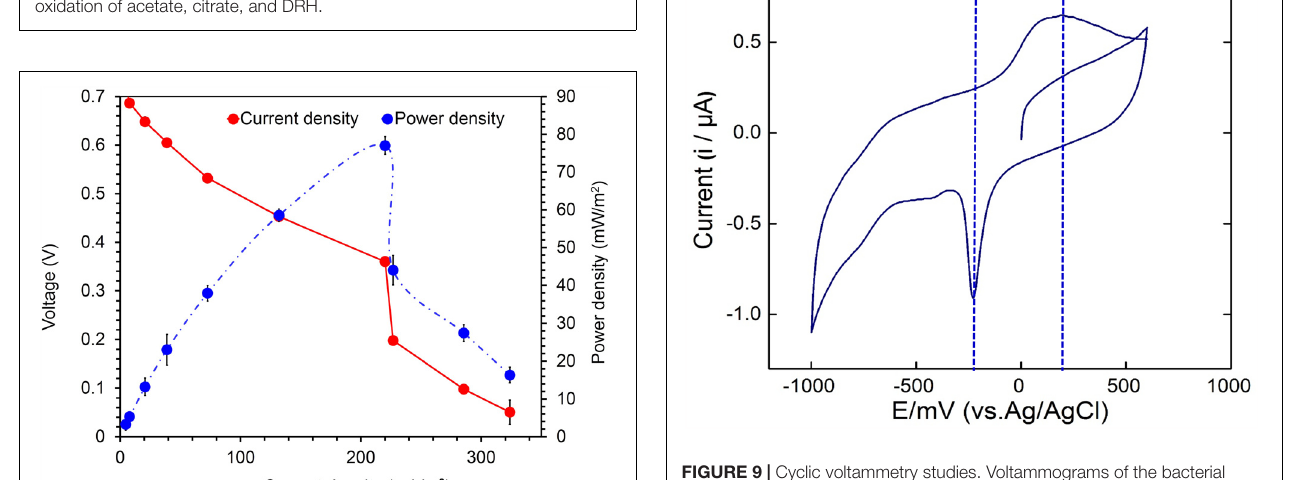
FIGURE 9 | Cyclic voltammetry studies. Voltammograms of the bacterial suspension prepared from anaerobically grown cells of Citrobacter